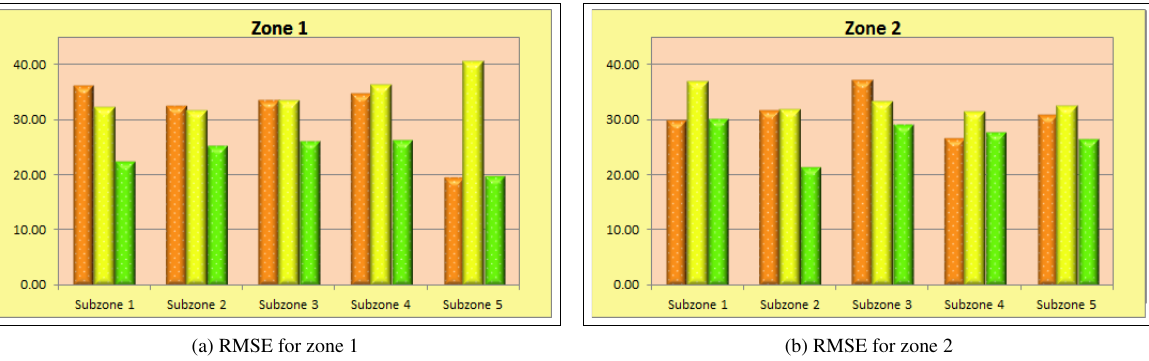
Figure 10. Prediction error reported using RMSE for five exclusive subzones in two